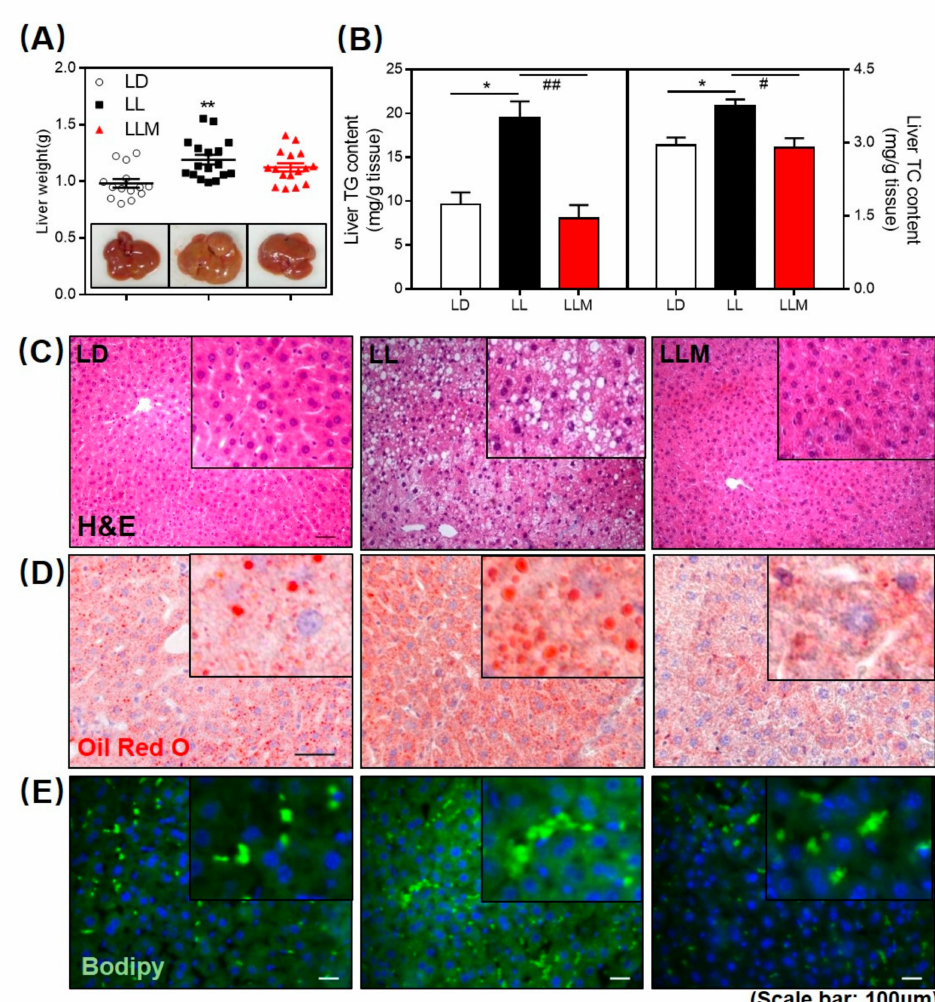
Figure 3. Melatonin decreases fat accumulation in the livers of HFD-fed mice with constant light. ( A ) Representative images of liver and liver weight. ( B ) Liver TG and TC contents. ( C ) H&E staining, ( D ) Oil Red O, and ( E ) BODIPY staining of liver sections (scale: 50 µ m). Values are presented as the mean ± SEM. N = 16–20, * p < 0.05; ** p < 0.01; *** p < 0.001 compared with LD, # p < 0.05; ## p < 0.01; ### p < 0.001 compared with LL by one-way